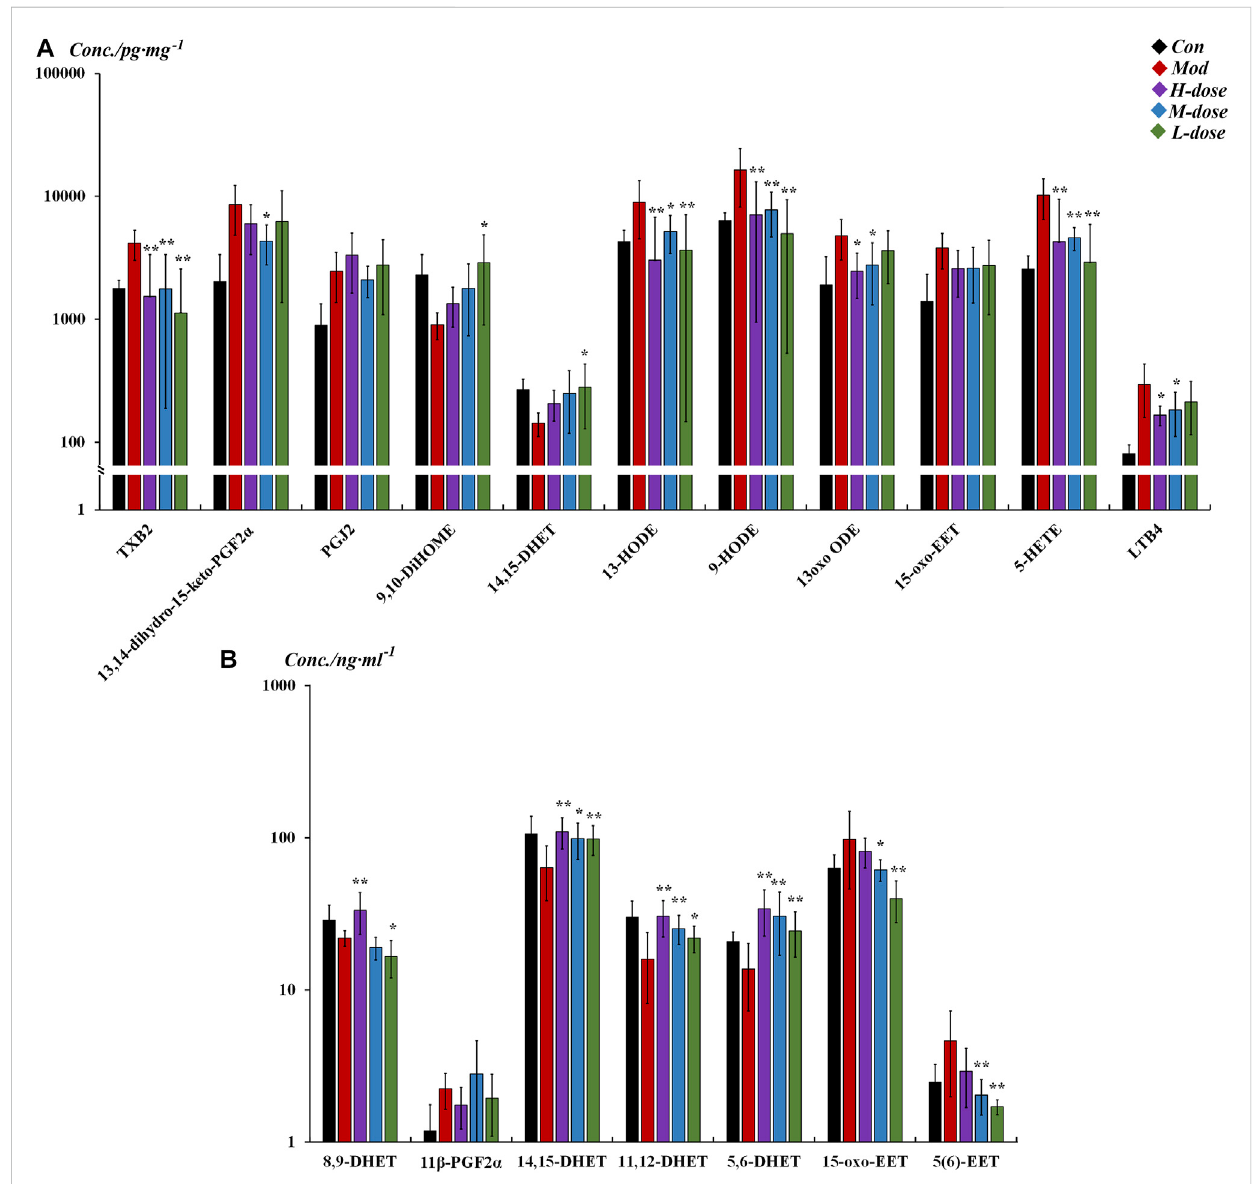
Different LM regulation capabilities between different groups in lung tissue and serum (All listed LMs were found to be signi fi cantly changed [ p < 0.05] in tissue between control and model groups, with SXCF treatment, some of these LMs were found to be signi fi cantly changed [ p < 0.05]). (A) LMs with signi fi cant changes in lung tissue, (B) LMs with signi fi cant changes in serum. n = 6, ** vs . Mod, p ≤ 0.01, *0.01 < p < 0.05, data were expressed as mean ± standard deviation (one-way ANOVA followed by LSD